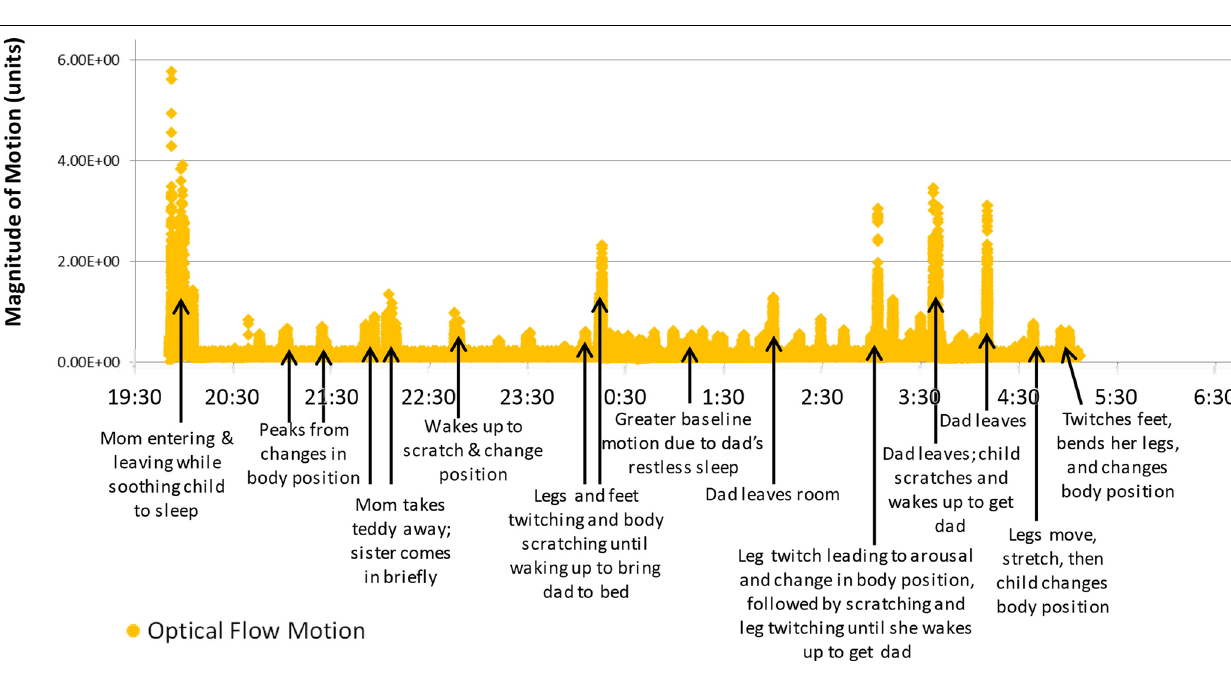
FIGURE 6 | Optical Flow © diagram . This diagram shows the results of Optical Flow analysis of the case vignette HVS-recording. Time is displayed on the horizontal axis (total period of one night); magnitude of motion calculated using